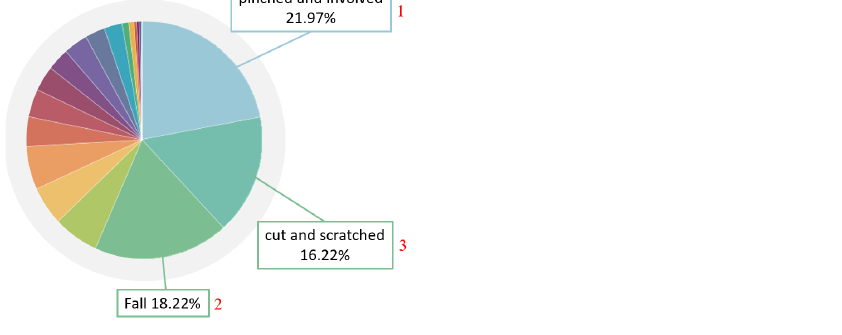
Figure 1. Occupational accident statistics of the Labor Insurance Bureau of Taiwan in 2020 [5].